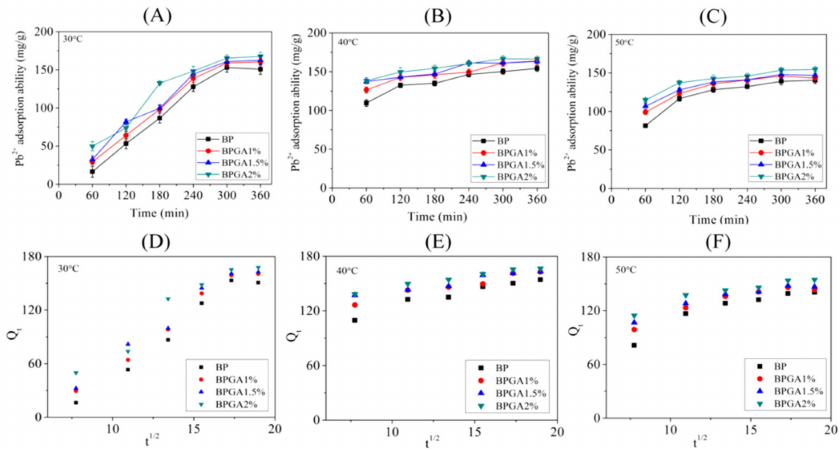
Figure 8. The adsorption kinetics of Pb 2 + onto the prepared adsorbent materials at 30 ◦ C ( A ), 40 ◦ C ( B ) and 50 ◦ C ( C ); intraparticle di ff usion models for the adsorption of Pb 2 + at 30 ◦ C ( D ), 40 ◦ C ( E ) and 50 ◦ C ( F